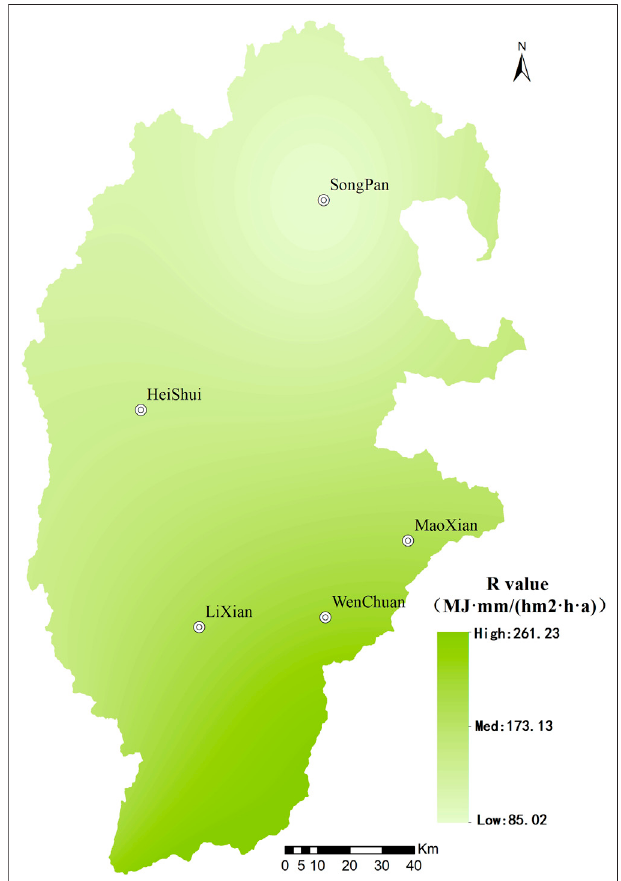
FIGURE 3 | Distribution of rainfall erosivity factor R in the upper reaches of the Minjiang